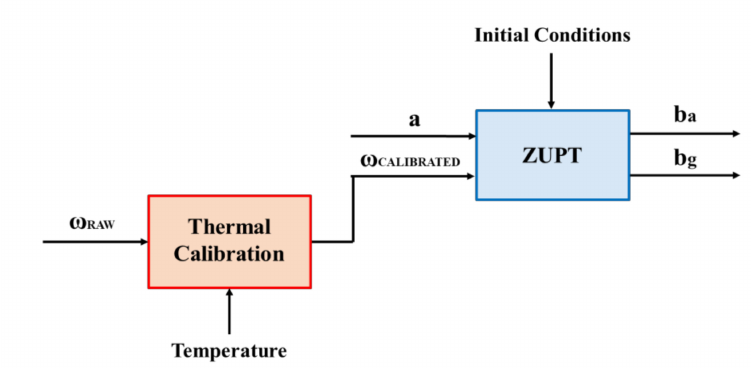
Figure 2. Standard ZUPT filter: a is the accelerometer output, ω RAW is the raw gyro data, ω CALIBRATED is the calibrated gyro data and b a and b g are respectively the accelerometer and gyro